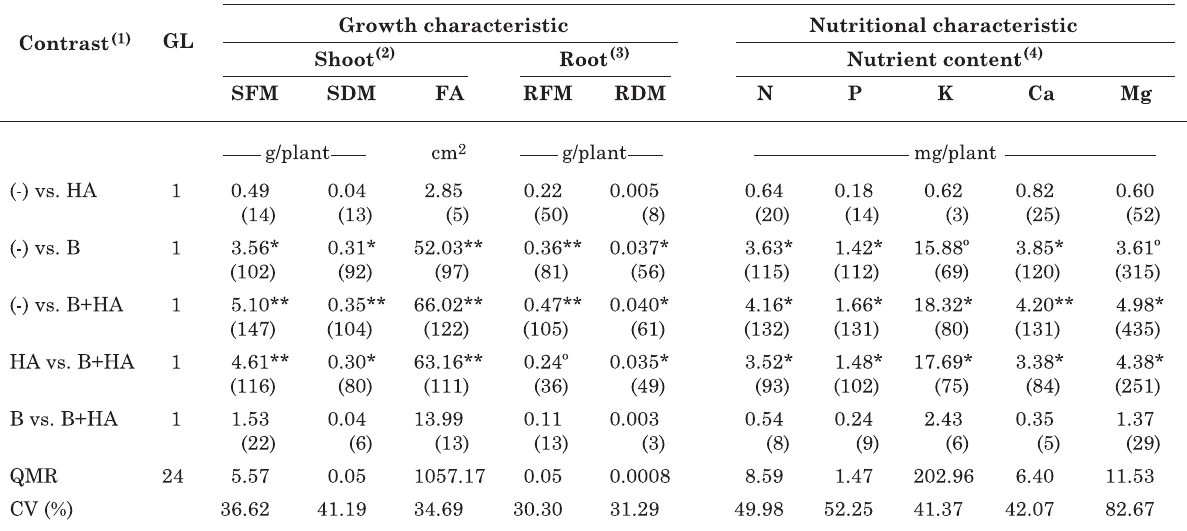
Table 3. Mean contrasts, relative increments, average square of the residue (QMR) and coefficient of variation (CV) for shoot and root fresh and dry matters, and nutrient accumulation in ‘Vitória’ pineapple plants in response to the application of humic acid and plant growth-promoting bacteria during